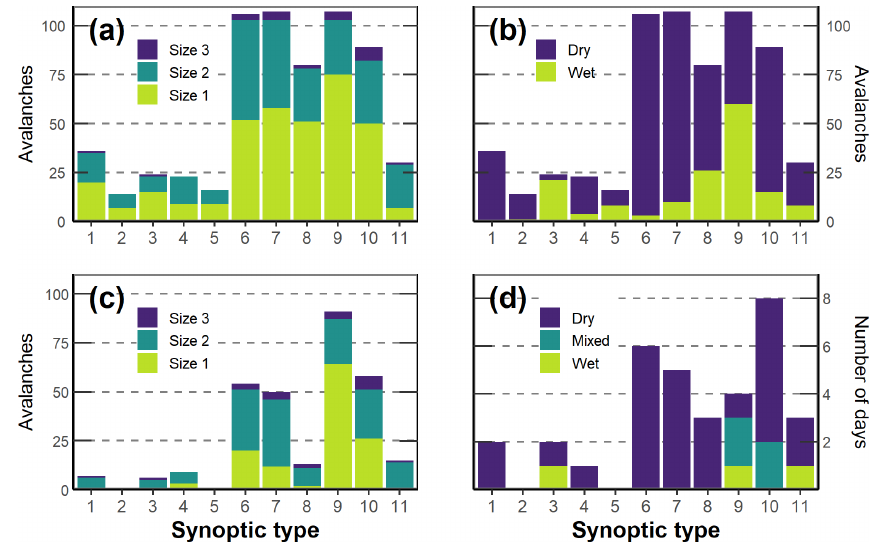
Figure 9. Avalanche activity by synoptic type denoted by the numeric identifier. Panel (a) displays the total number of observed avalanches of each destructive size for each synoptic type. Panel (b) shows the total number of wet and dry avalanches observed during days of each synoptic type. Panel (c) displays the total number of observed avalanches of each destructive size on high-activity days of each synoptic type, and panel (d) displays the number of high-activity days classified by avalanche activity wetness for each synoptic type.